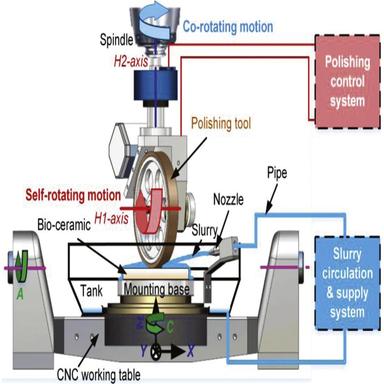
Schematic illustration of the dual-axis wheel polishing technology.